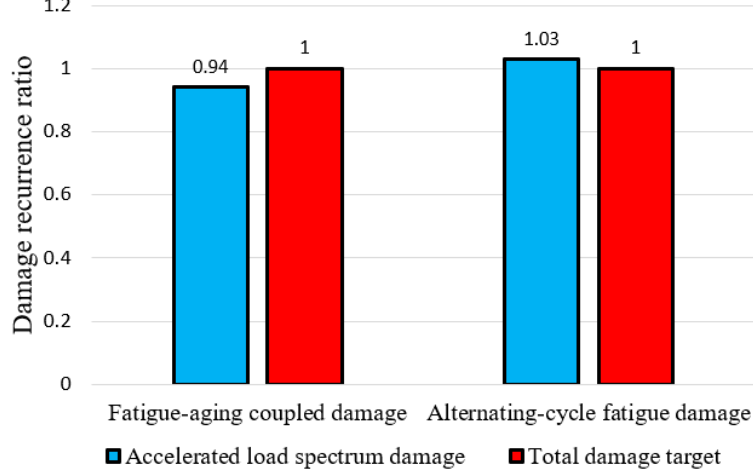
Figure 31. Damage recovery ratios for both failure